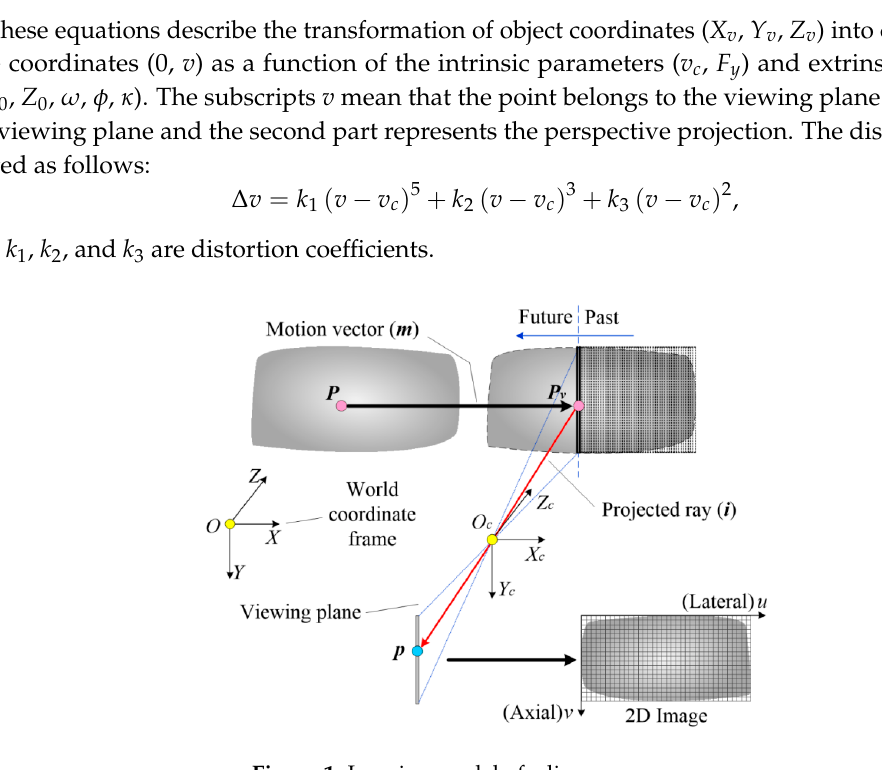
Figure 1. Imaging model of a line-scan camera.